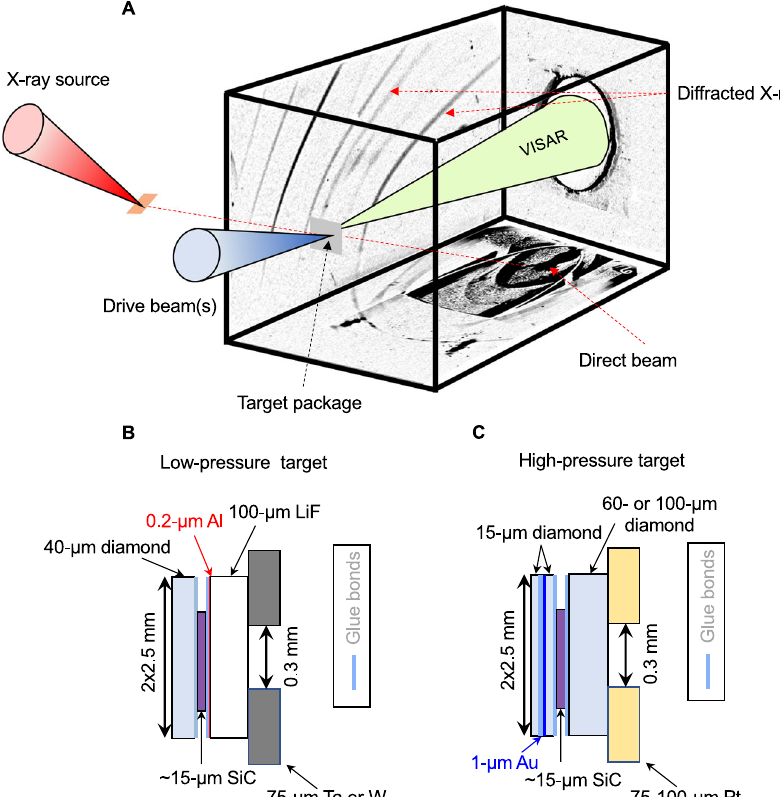
Fig. 1 Experimental set-up and target packages for laser-driven compression. a The drive laser (blue cone) generates stress waves through the C/SiC/ window target package (gray square). The stress rapidly equilibrates in the SiC foil following reverberation of the compression waves due to impedance mismatch with the diamond and window interfaces. A quasi-monochromatic X-ray source was generated by laser irradiation (red cone) of a Cu or Ge foil (orange square). The diffracted X-rays from the target are recorded on image plates inside of a detector box. Target assemblies used for low-stress (<400 GPa) and high-stress (>400 GPa) experiments are shown in b and c , respectively. The front diamond surface is illuminated by the drive laser using distributed phase plates (800- or 1100- μ m focal spot). The incident X-rays are collimated using a 300- μ m diameter pinhole (W, Ta, or